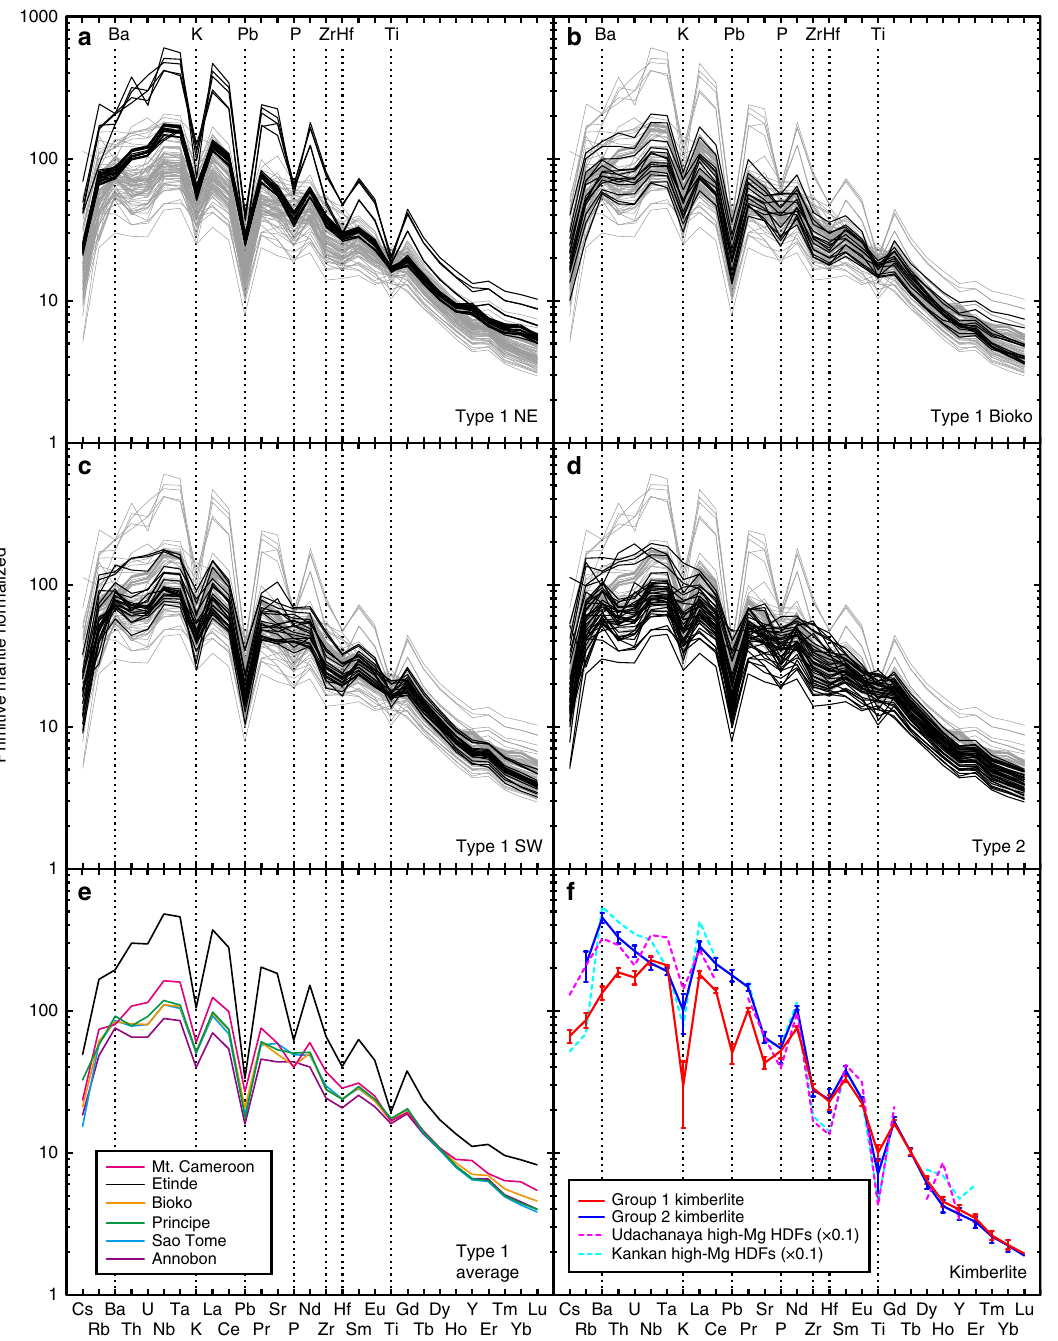
Fig. 2 Primitive mantle-normalized trace element patterns of Cameroon volcanic line lavas. a Type 1 northeastern lavas (Mt. Cameroon 20 and Etínde) shown in black; b Type 1 Bioko shown in black; c Type 1 southwestern lavas (Principe, São Tomé, and Annobòn) shown in black; d Type 2 lavas shown in black; e average values of Type 1 lavas for each volcanic location; and f average values of Group 1 and Group 2 kimberlite from Africa and high-Mg carbonatitic high-density fl uids (HDFs) included in diamond from Udachanaya and Kankan kimberlites 26,67 . Patterns shown in grey in a – d are data for all of the Cameroon volcanic line. Error bars of the kimberlite values represent 1 standard error. To facilitate visualization, the data for HDFs were multiplied by 0.1. The altered samples (indicated in Supplementary Data 1) are not plotted. The source data of the compiled values in f are provided in ref. 66 . Primitive mantle normalizing values are after ref. 68 . Elements discussed in the main text are labelled with broken